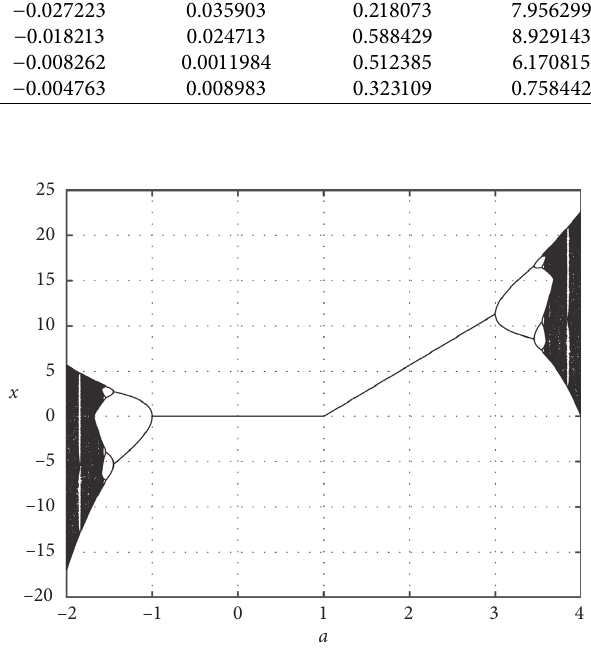
Figure 4: Bifurcation diagram of system states versus